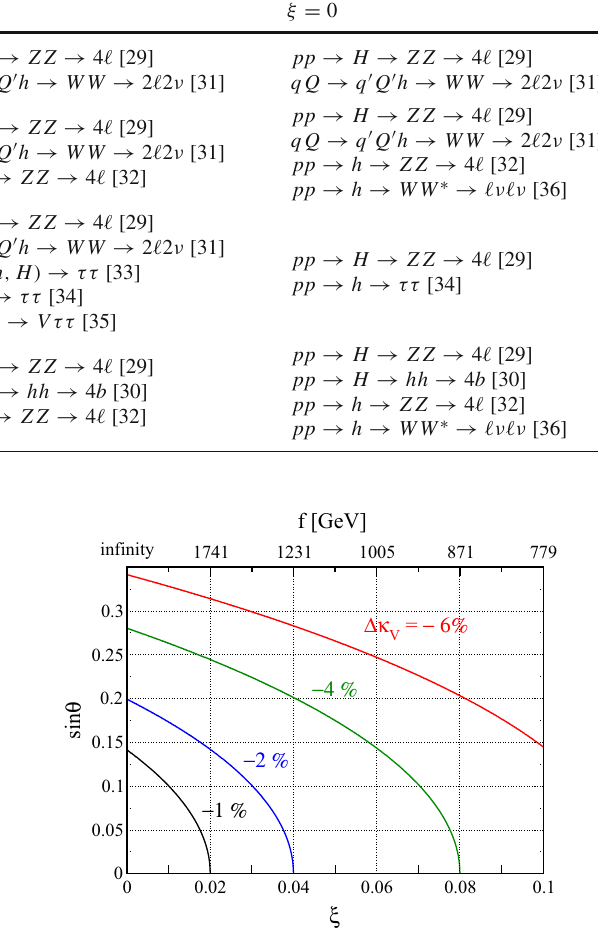
Fig. 2 Contour plot for the deviation in the hV V couplings (cid:18)κ κ − 1 from the SM prediction V